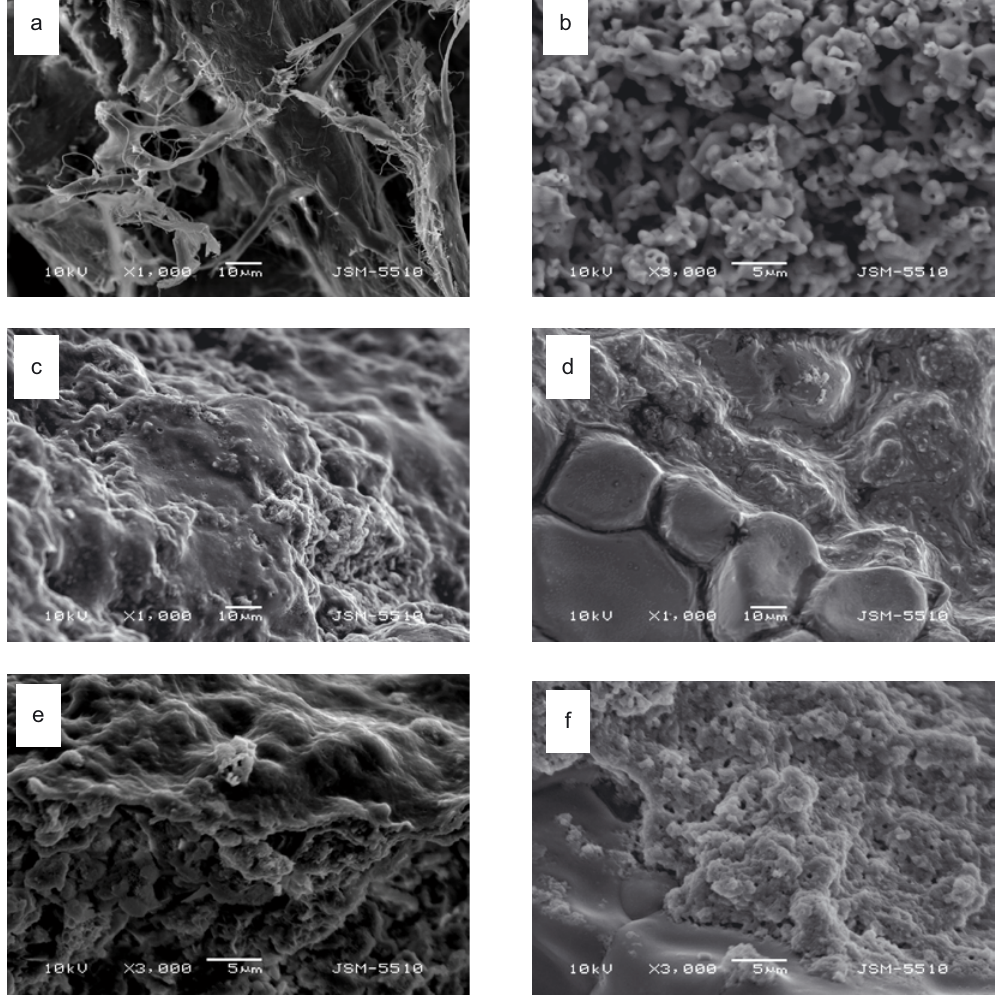
Figure 7. SEM images on collagen CPS/W hybrids: pure collagen (a), CPS/W sample, thermal treated at 1200°C/2 h (b), C-CPS/W-75:25 wt.% before SBF (c), C-CPS/W-25:75 wt.% before SBF (d), C-CPS/W-75:25 wt.% after SBF (e), C-CPS/W-25:75 wt.% after SBF